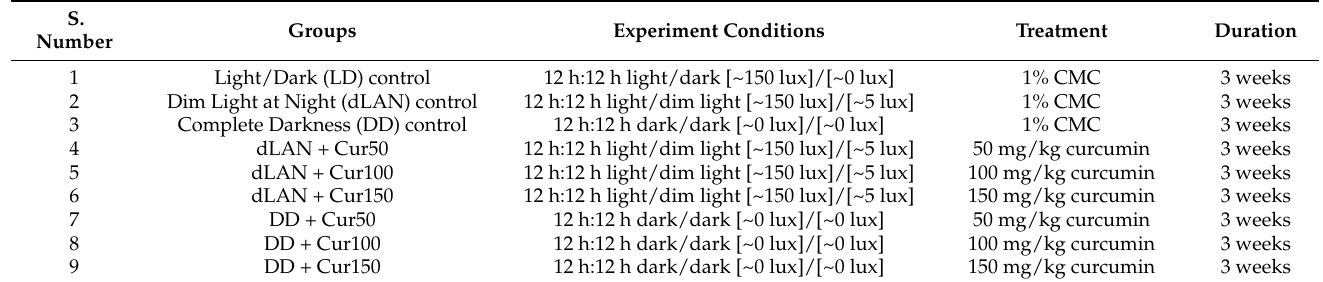
Table 1. Experimental design ( n = 5) mice in each